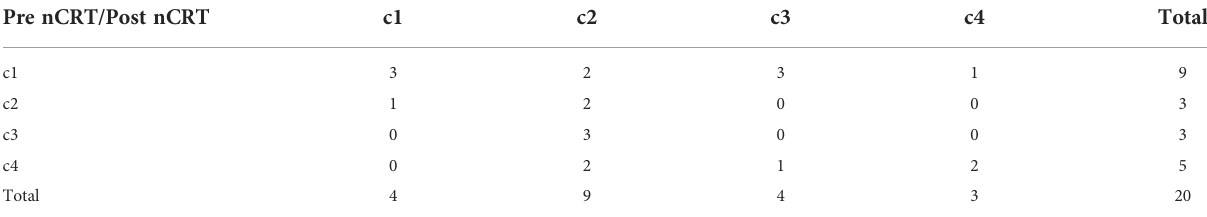
TABLE 1 Immune subtypes in matched samples before and after nCRT in